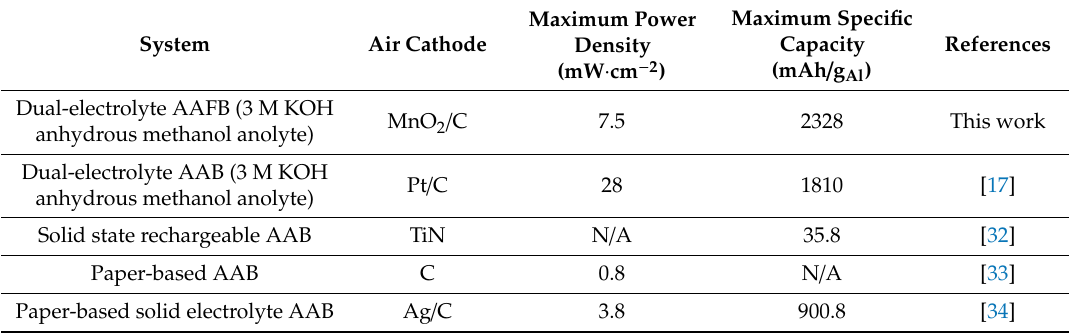
Table 5. Comparison of the battery developed in this work and other AABs that have been previously